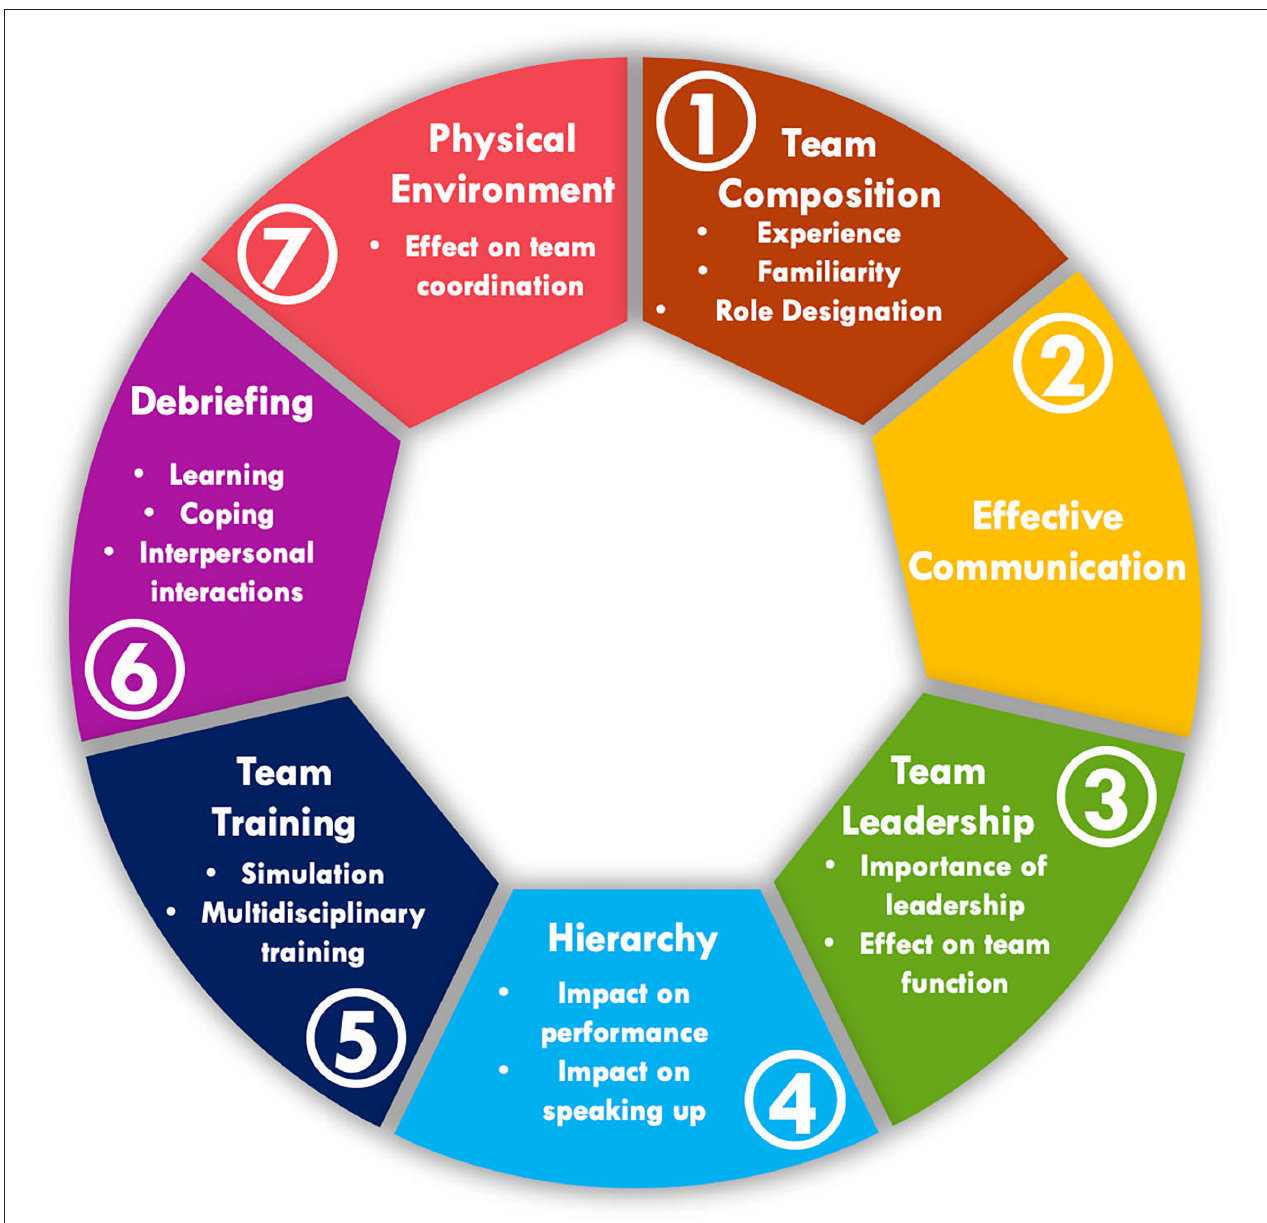
FIGURE 1 | Themes and subthemes